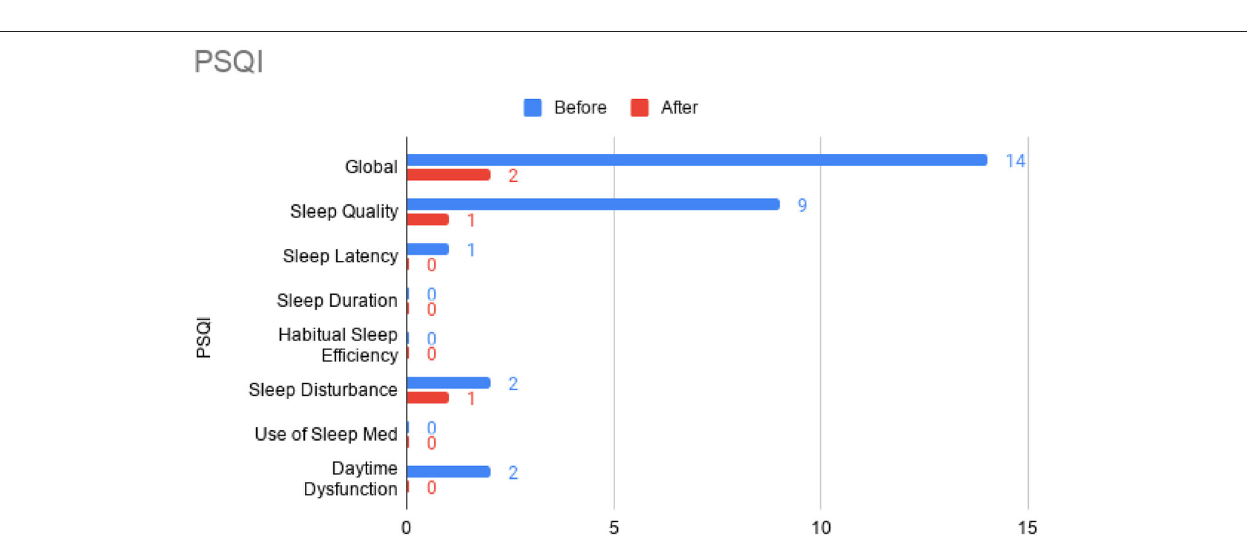
FIGURE 5 | Pittsburgh Sleep Quality Index (PSQI) sub-scores prior to the initiation of omalizumab (blue) and after the 6 month treatment period